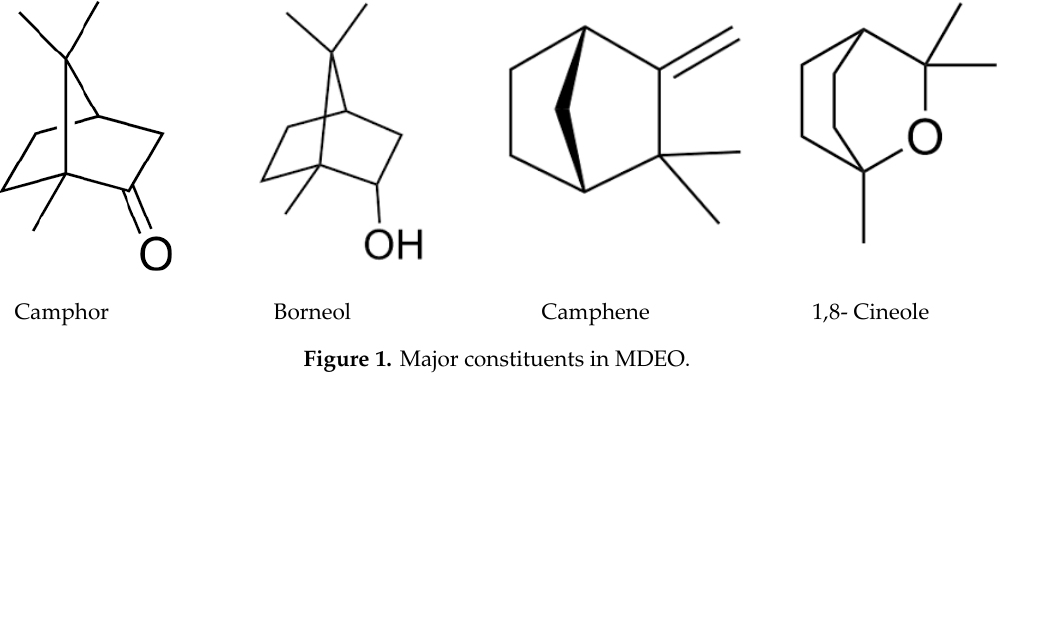
Table 2. Cytotoxic activity of Meriandra dianthera essential oil (MDEO) on three cancer cells.